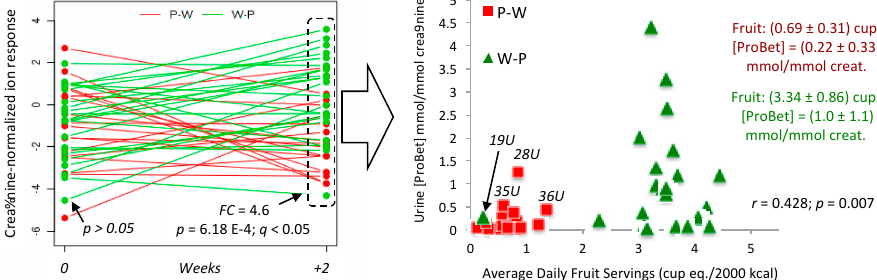
Figure 4. Metabolic trajectories for two dietary biomarkers in plasma and urine that increased following a Prudent diet (W-P) as compared to a Western diet (P-W), namely ( A , B ) Me-His and ( C , D ) ProBet. Both metabolites were not different at baseline, but undergo significant changes after two weeks of assigned food provisions ( q < 0.05, FDR) with concentrations moderately correlated ( r > 0.400) to self-reported diet records, such as a higher average daily intake of fruit (ProBet) and protein (Me-His). Good dietary adherence was demonstrated for most DIGEST participants with only a few exceptions (labeled on plots), who had metabolic phenotypes inconsistent with their assigned diets following two weeks of food provisions.